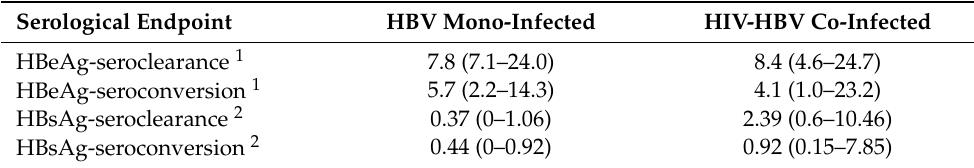
Table 2. Median rates (range) of serological endpoints related to hepatitis B “e” antigen and hepatitis B surface antigen during treatment for chronic hepatitis B virus